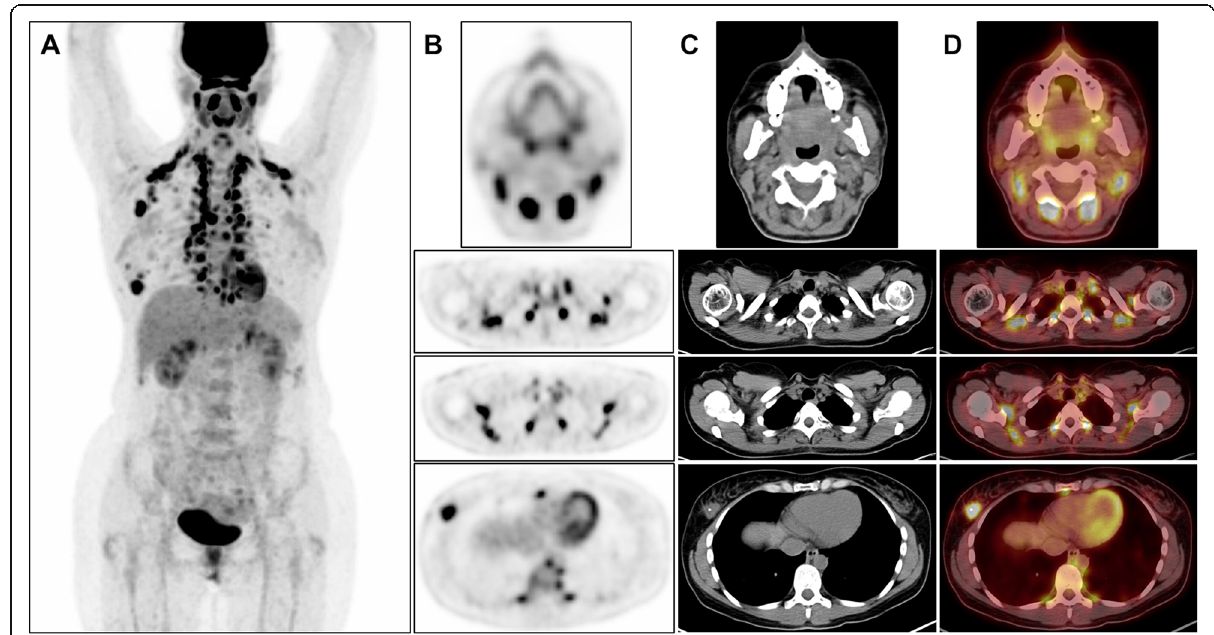
Fig. 1 Brown fat uptake: 18 F-FDG PET/CT scan of a 45-year-old female with luminal A invasive ductal carcinoma of the right breast: a maximum intensity projection, b transaxial PET show intense 18 F-FDG uptake in the cervical, supraclavicular, paravertebral, and mediastinal regions. c The corresponding CT and d transaxial PET/CT fusion images reveal that 18 F-FDG uptake is corresponding to fatty tissue, and there is no abnormal lymph node or muscle uptake, denoting activated BAT. The last row show intense FDG-avid primary lesion at the lower outer quadrant of the right breast with a metallic clip in situ, as well as foci of activated BAT at paravertebral, and mediastinal regions